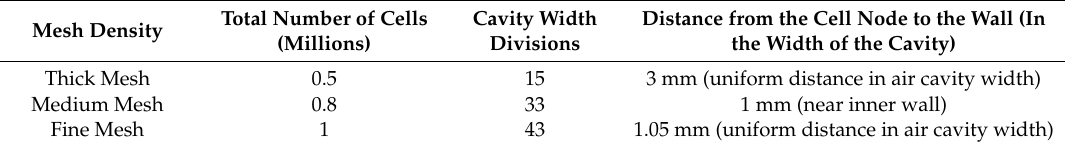
Table 2. Mesh discretization cases evaluated in the sensitivity analysis.